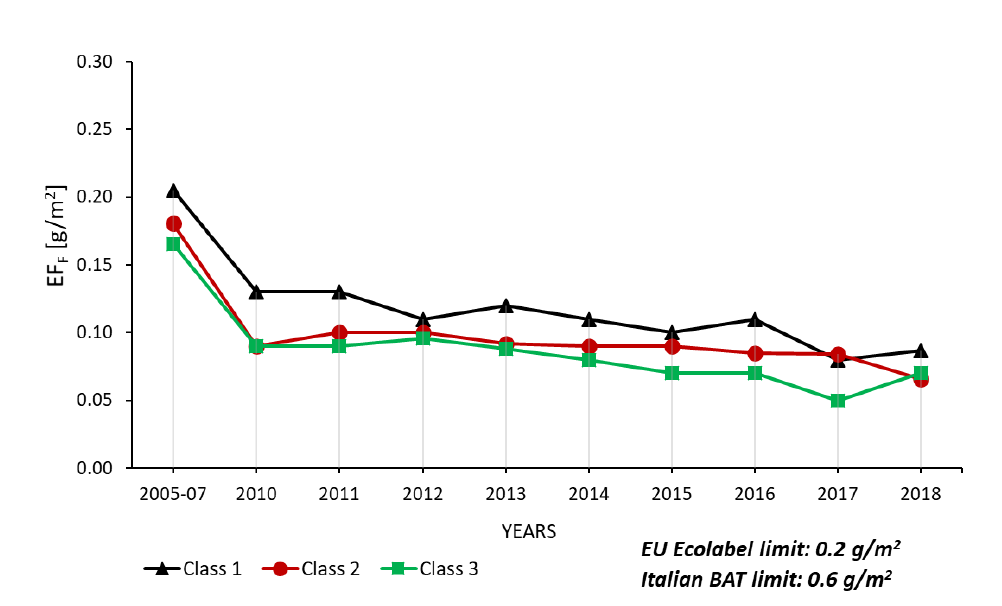
Figure 4. Trend for the emission factor of fluorine (EF F ) for the three production classes.